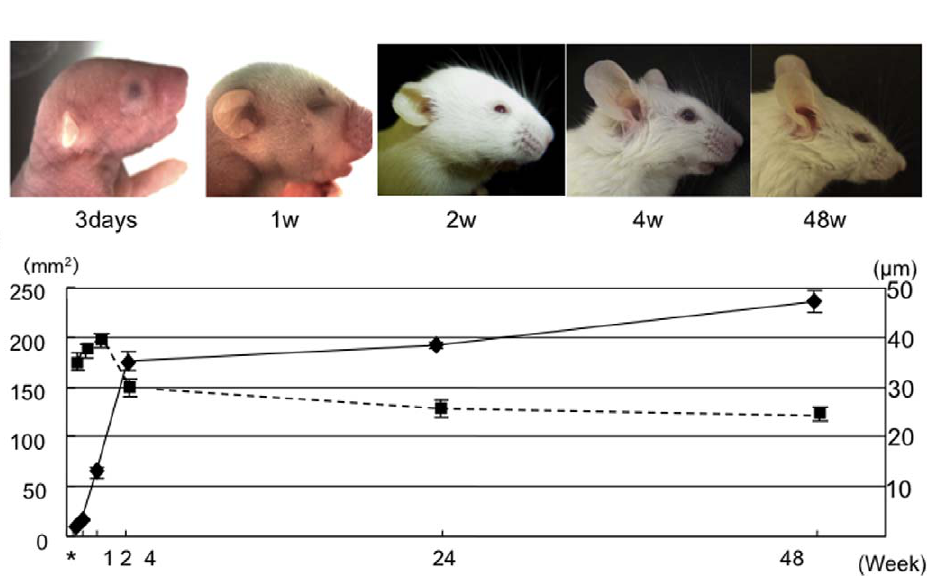
Figure 1. Development of murine external ears. (A) The external ear at several developmental stages. From the left, ears were photographed 3 days, 1 week, 2 weeks, 4 weeks, and 48 weeks after birth. (B) Mean surface area of the external ear and mean thickness of auricular cartilages changed during postnatal development. * ; 3 days, ; mean surface area of the external ear (mm2), ; mean thickness of auricular cartilage in the middle area of the external ear ( m m)